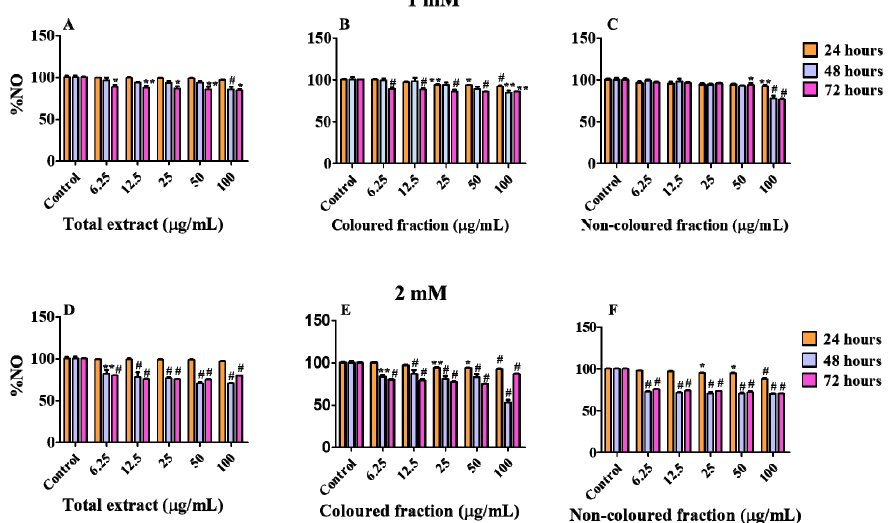
Figure 8. Nitric oxide (NO) levels in HepG2 cells pre-treated for 24 h with each extract and then incubated with 1 mM ( A – C ) and 2 mM ( D – F ) of sodium nitroprusside for further 24, 48 and 72 h. Values show mean ± SEM of five independent assays performed in triplicate compared to the respective control (* p < 0.05, ** p < 0.01 and # p <